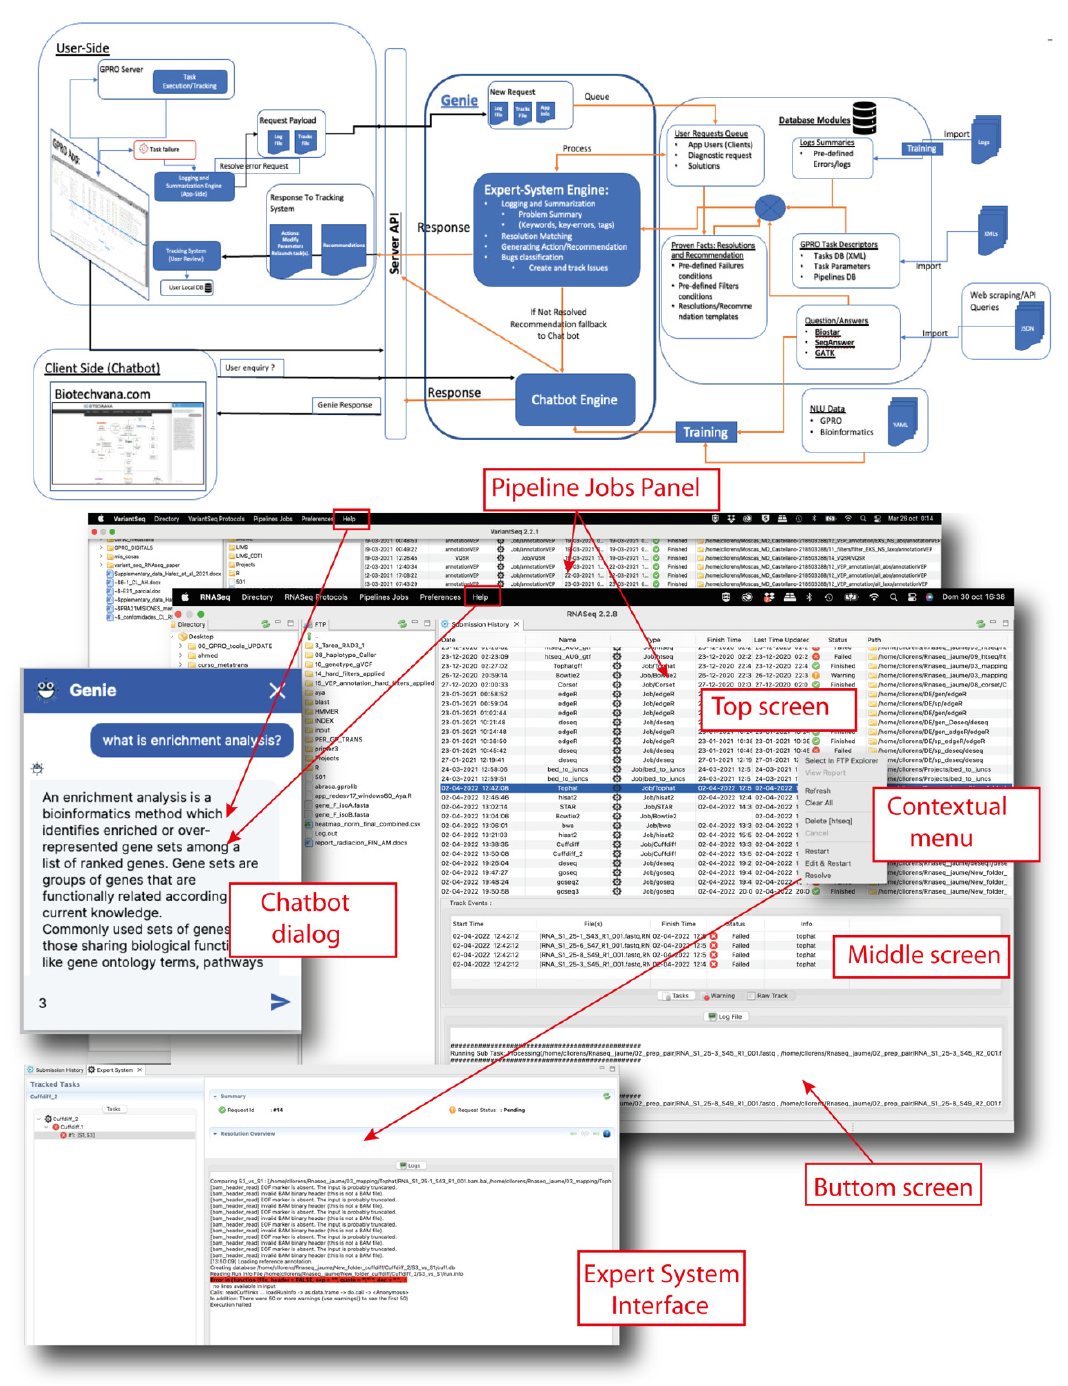
Figure 5. User support system. Schematic of the GENIE AI system. The chatbot and expert system engines and their knowledge databases are hosted on a remote GPRO server that communicates with the client applications and GSS via API. Each application presents a dialog available in the Help section of the Top Menu where the chatbot can be asked questions. Each application also has a pipeline jobs panel, which is a dynamic interface that summarizes all jobs summitted to the GSS and that provides information across three screens (Top, Middle, and Bottom) about the status of each specific job; specifically, if the job finished correctly (green icons), had some warnings (orange icons), or failed (red icons). By right clicking on the panel, a contextual menu will appear to provide tasks to manage the panel (described in text) and the expert system (shown at the bottom of the figure).